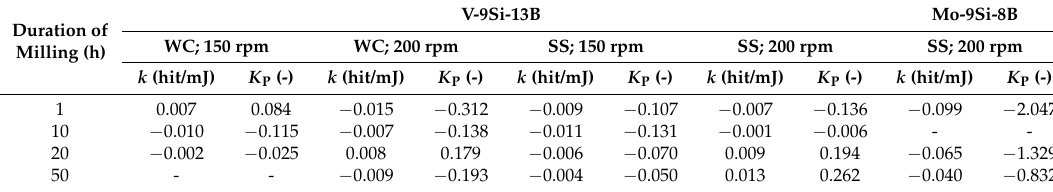
Table 3. Grindability k and comminution rate K P of V-9Si-13B and Mo-9Si-8B powders depending